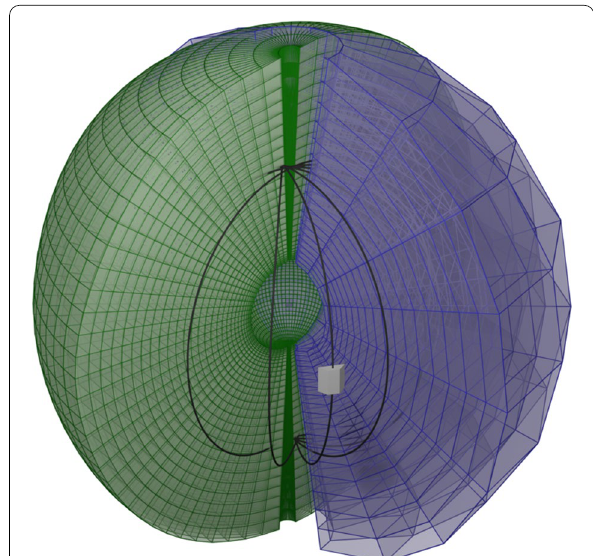
Fig. 1 The green lines illustrate the grid of the TIE-GCM at one epoch. We call it the state grid . The blue lines show the (constant) grid at which we evaluate the NRLMSIS 2.0. We call it the data grid . The black curve illustrates the orbit of the CHAMP satellite for some revolutions. In the two-step approach we first calibrate the NRLMSIS 2.0 with the accelerometer-derived density of the CHAMP satellite, and evaluate it on the data grid . In a second step we assimilated the densities located on the data grid —in data assimilation terminology this are the observations—into the TIE-GCM. The grids appear thicker as they are in reality, since the radius of Earth is not added. Actually both grids cover the entire Earth, but we show only a subset for a clearer